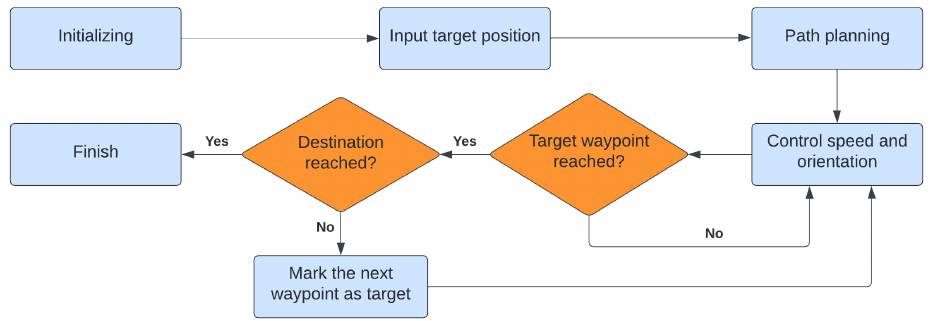
Figure 16. The control process. (Blue color represents the actions, orange color represents the decisions.)